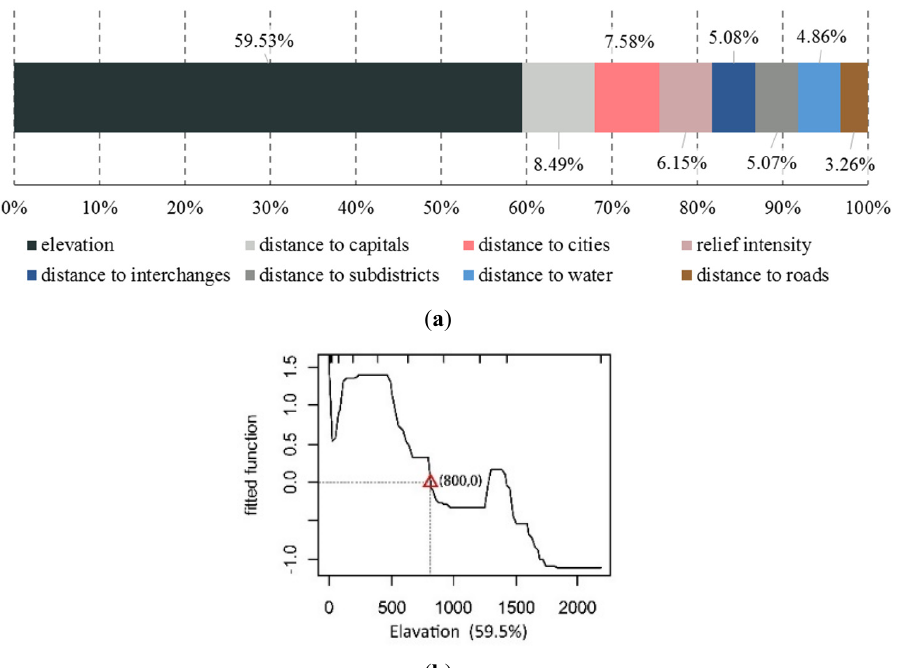
Figure 10. Factor contribution ranking and marginal effect of ES–PS. ( a ) Contribution degree of factors; ( b ) marginal effect of factor which contribution degree over 10%.